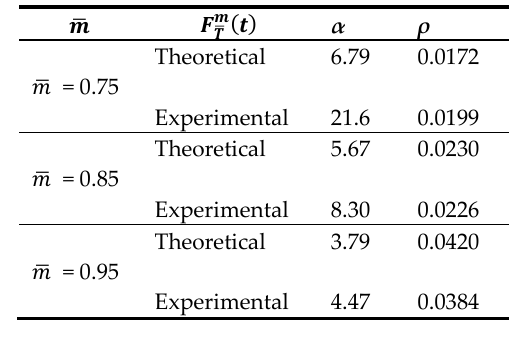
Figure 9. Scenario 3: ( a ) Comparison between experimental curves obtained for scenario 3 and the fragility curves defined as “statistical truth”. ( b ) Parameters of the theoretical and experimental distributions compared.